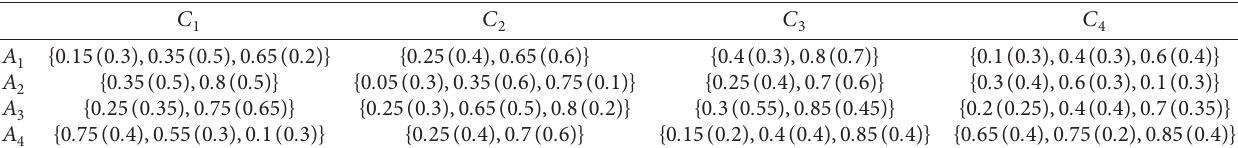
Table 6: Probabilistic hesitant fuzzy decision matrix given by the